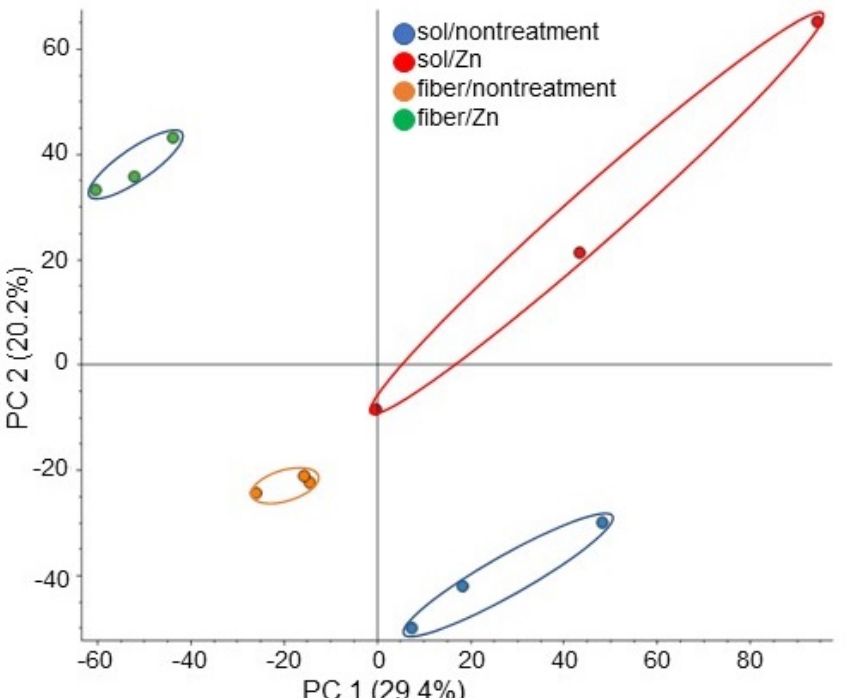
Figure 3. Overview of total proteomic data from 12 samples based on PCA. Proteins from soybean roots including hypocotyl treated with or without 1 ppm ZnO NPs with 200 nm in solution or BL-fiber were extracted and analyzed using a LC-MS. Blue, red, orange, and green colors indicate nontreated solution, ZnO NPs solution, nontreated fiber, and fiber crosslinked with ZnO NPs sample groups, respectively. Three biological replicates were performed in each group.